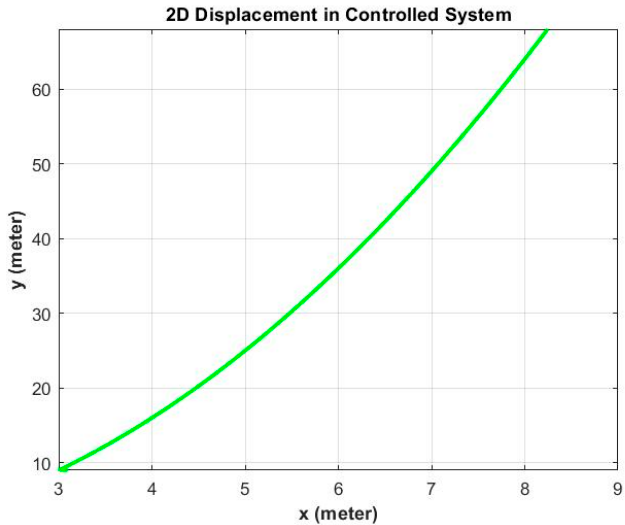
Figure 10. The ship tracking path in the controlled system .